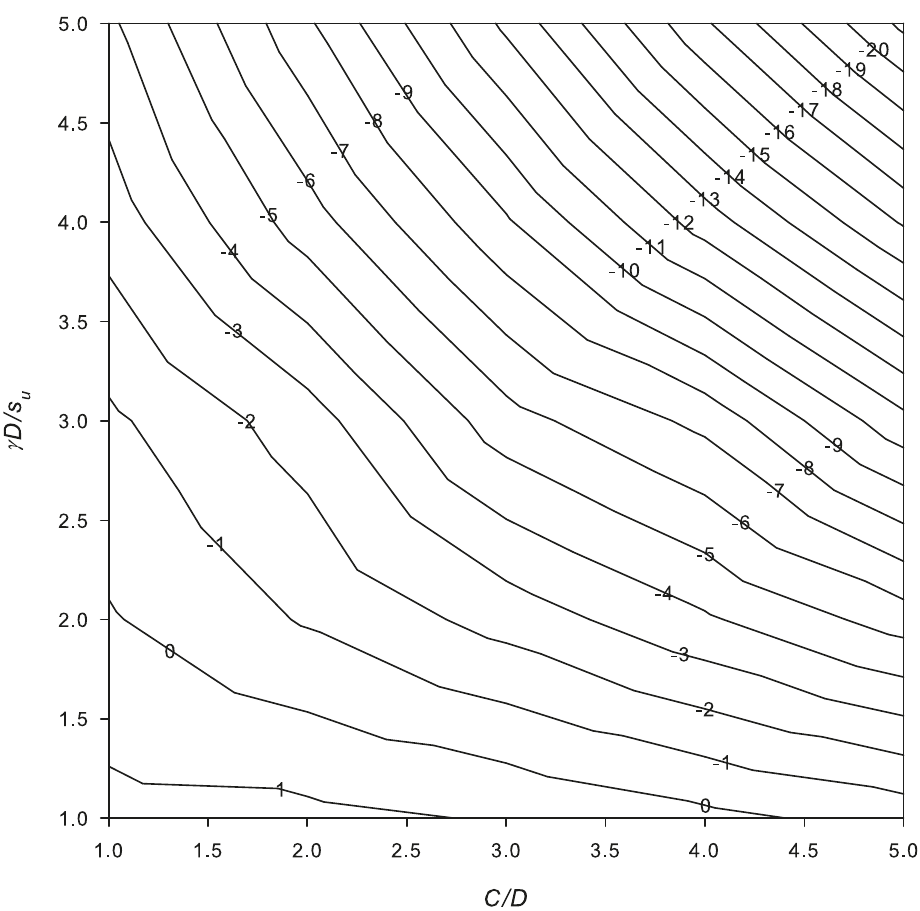
Figure 8. Contour plot of critical stability numbers, N = ( σ s − σ t ) / S u , obtained from this study.